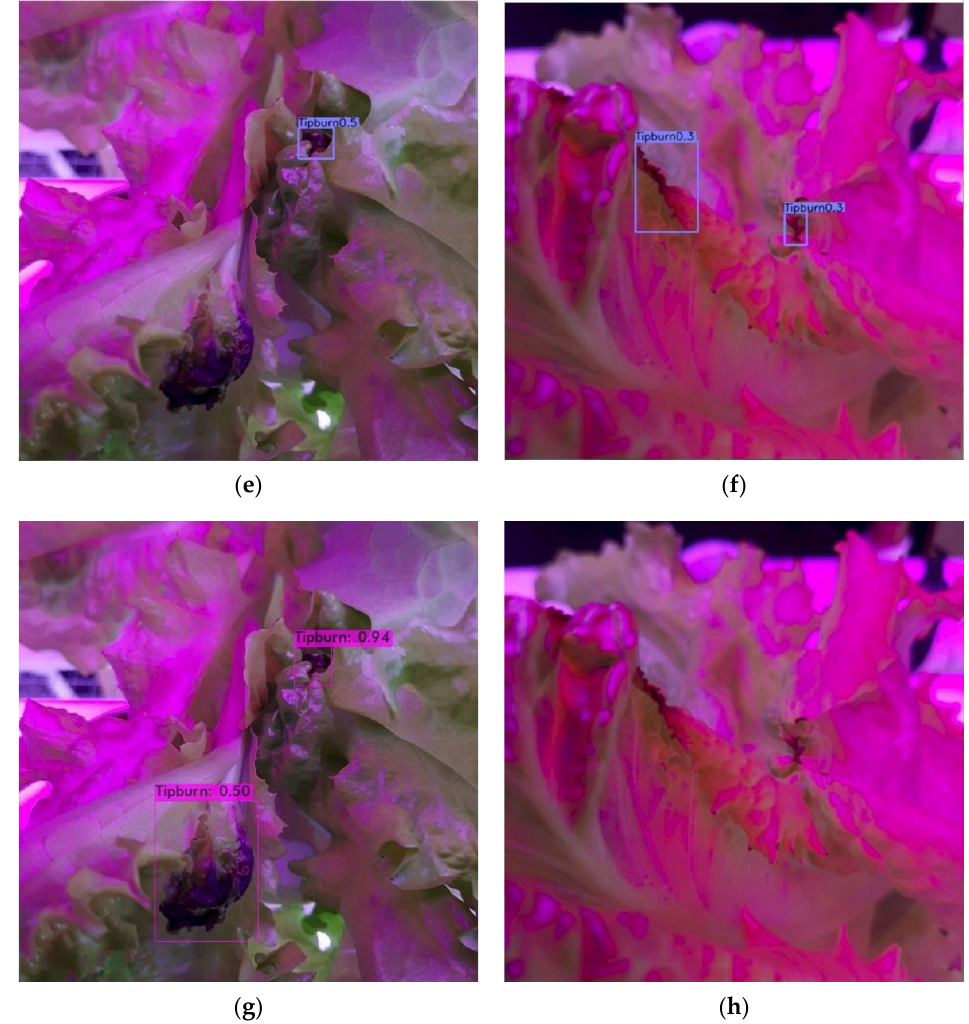
Figure 7. Detection of tip-burn under red/blue light conditions from ( a , b ) manually labelled; ( c , d ) YOLOv5; ( e , f ) CenterNet; ( g , h ) YOLOv4.